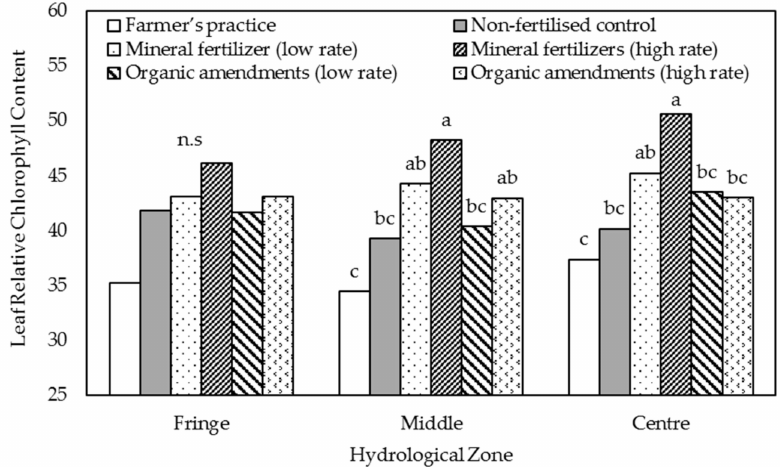
Figure 4. Leaf relative chlorophyll content values of maize at tasseling from three hydrological positions and under di ff erent crop management